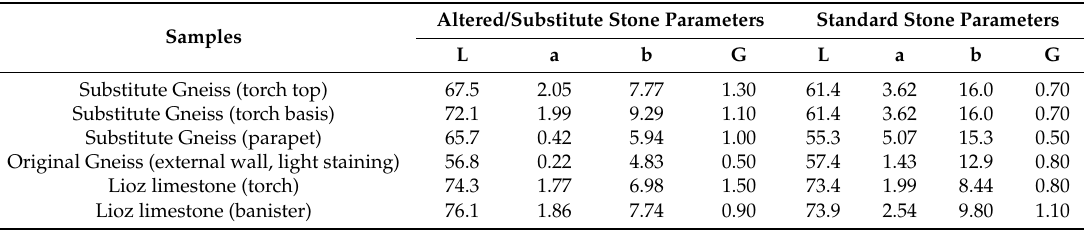
Table 2. Lab * parameters for the analyzed samples.